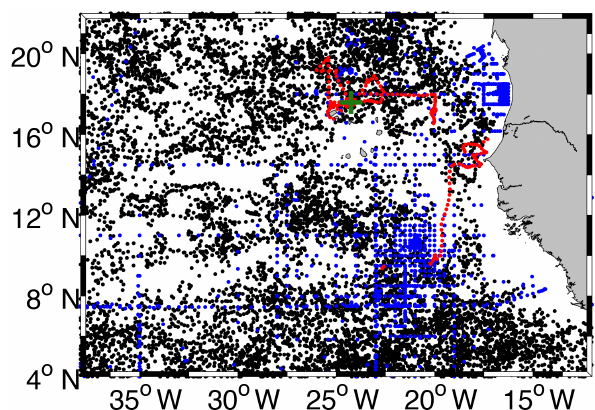
Figure 2. Map of the ETNA containing all available profiles be- tween 1998 and 2014. The green cross marks the CVOO position, blue dots mark shipboard conductivity–temperature–depth (CTD) stations, red dots mark the locations of glider profiles and black dots locations of Argo float